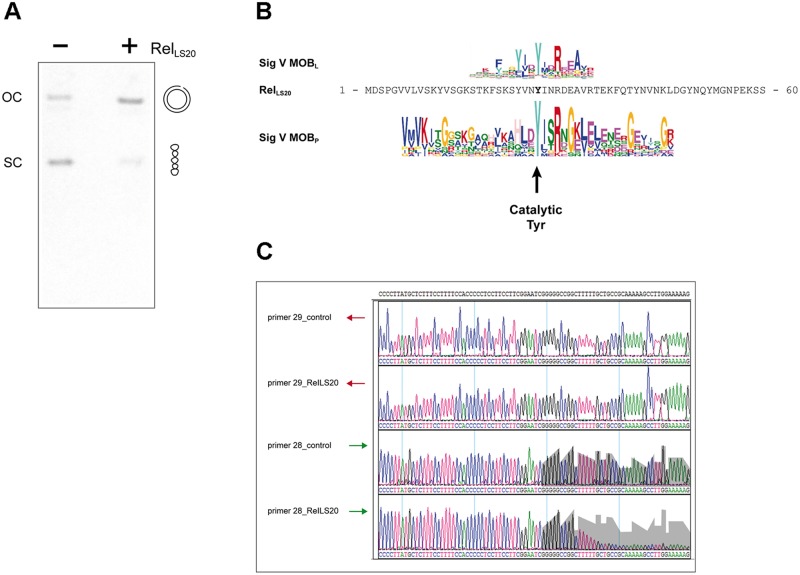
Determination of the catalytically active tyrosine residue of RelLS20, and the position of the nick site within oriTLS20.(A) Plasmid pGR16B containing oriTLS20 was incubated in a buffer lacking (-) or containing (+) purified RelLS20. Next, both samples were treated with proteinase K and DNA was run on a 0.8% agarose gel. The positions of supercoiled (sc) and nicked open circular DNA (oc) are indicated. (B) The N-terminal 60 residues of RelLS20 are aligned with the consensus sequences (presented as weblogos) of signatures 5 of the MOBL and MOBP type relaxases. The position of the catalytic Tyrosine residue of MOBP type relaxases is indicated with a vertical arrow. (C) Samples of pGR16B with (RelLS20) or without (control) prior incubation with RelLS20 were used as template DNA in sequencing reactions using forward primer 28 or reverse primer 29. The area of grey background, corresponding to the signal strength obtained with the control sample, is duplicated and overlaid to the same positions of the chromatogram of the RelLS20-treated sample to highlight the drop in signal intensity. Note that the intensities of the signals are very similar for other regions. The residual signal observed after the drop in signal intensity is due to the presence of low amounts of non-nicked plasmid DNA in the sample.